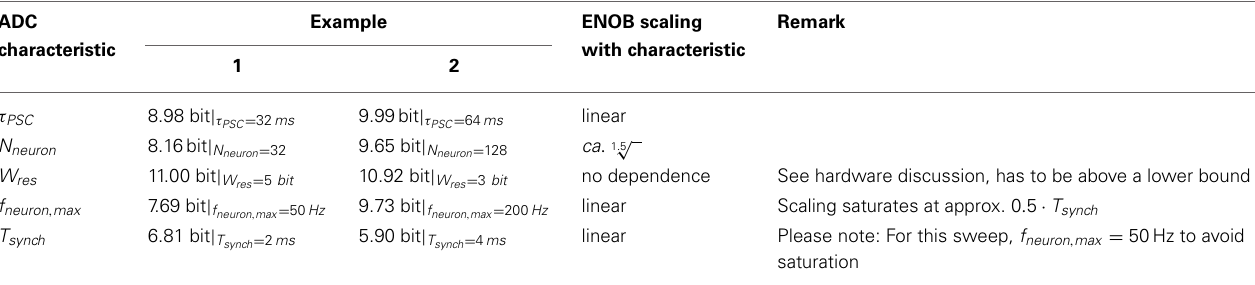
Table 2 | Scaling of ENOB with design characteristic/variable.